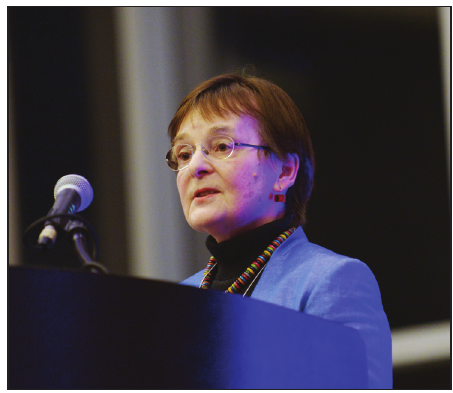
Figure 2: Elizabeth Pye speaking at the AIA Awards ceremony (Photo AIA).